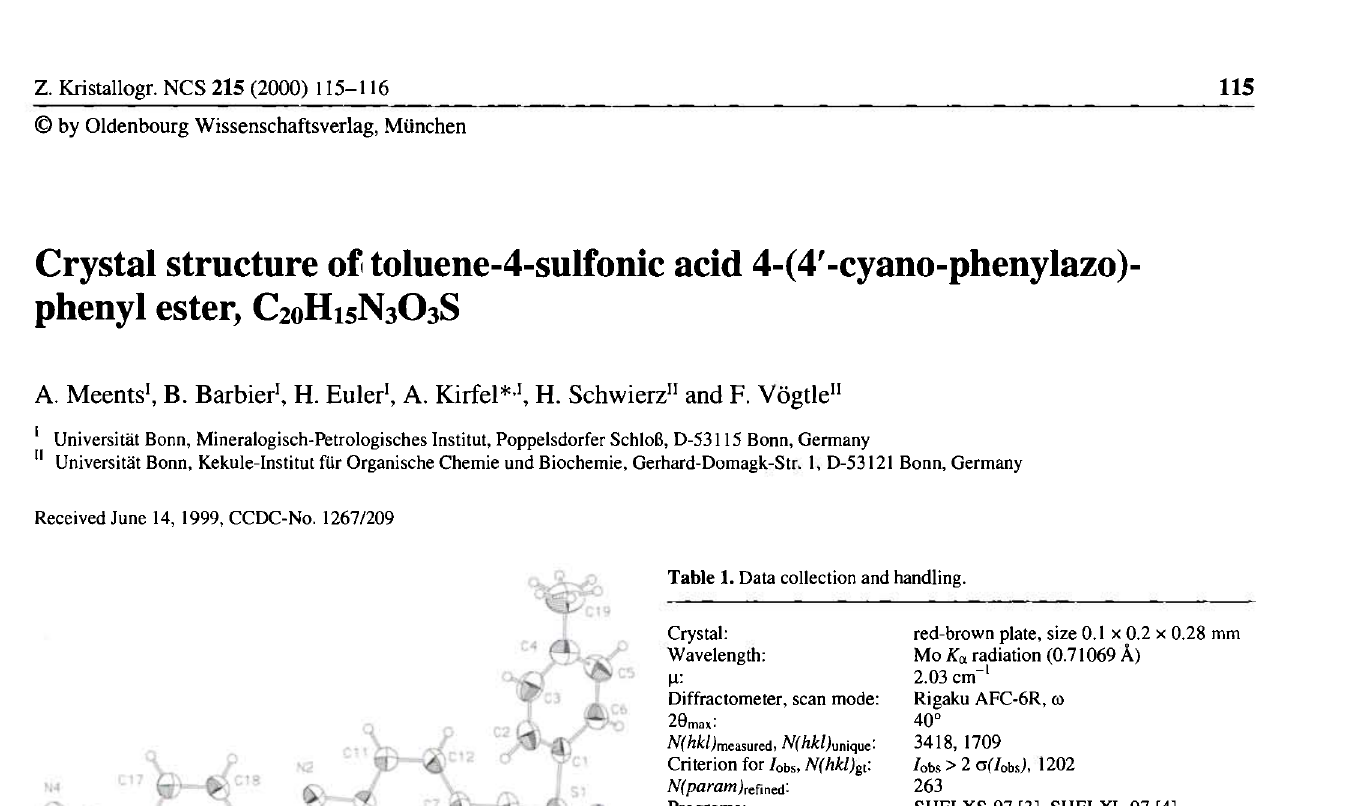
Table 2. Atomic coordinates and displacement parameters (in A 2